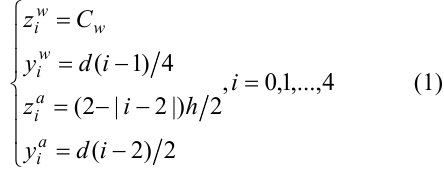
Fig. 1. Local coordinate system of biped robot.